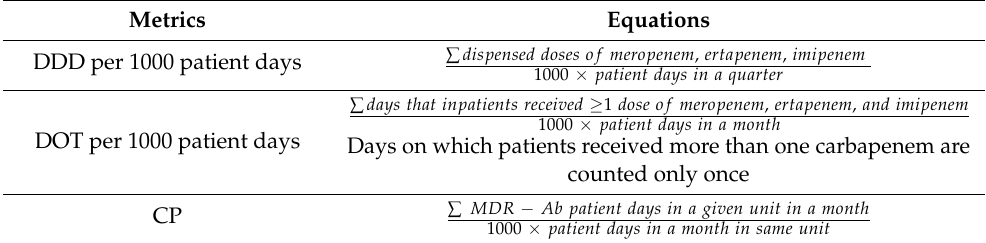
Table 1. Equations for Antibiotic Consumption Metrics and colonization pressure DDD, defined daily dose; DOT, days of therapy; CP, colonization